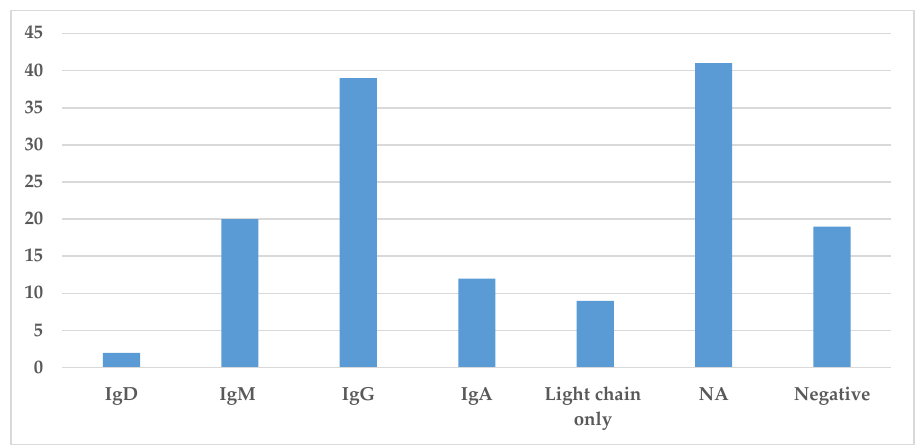
Figure 5. Prevalence of different immunoglobulins in Storing Histiocytosis. This figure demonstrates the distribution of immunoglobulin found in the serum by protein electrophoresis or immunofixation. Abbreviation: NA—not available. The type of light chain, i.e., either kappa or lambda light chains, is presented in Figure 6. Kappa light chain was the most common light chain associated with IgSH (65 cases),